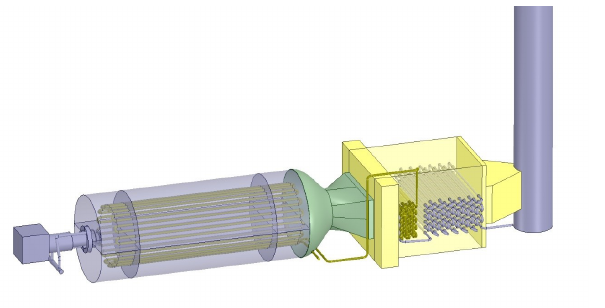
Figure 1. Schematic of the OTSG showing the burner, the radiant and the convection sections. The OTSG operations specs aim to achieve the wet steam of 80–90% steam quality (by mass). For this purpose, Boiler Feed Water (BFW) enters the horizontal convection section of the OTSG, where heat is exchanged from flue gases to the water running through the tubes. As illustrated in Figure 2, the BFW travels through a series of the finned tubes (Second Tubes in Figure 2) prior to exiting the OTSG and jumping to the first row of smooth tubes (First Tubes in Figure 2) closest to the OTSG flame. The BFW then run in co-current flow with the flue gases until it reaches the last row of smooth tubes and exits the convection section. The BFW then enters the radiant tube section located closest to the burner where the radiant heat from the burner flame further heats the water until the desired outlet steam quality is